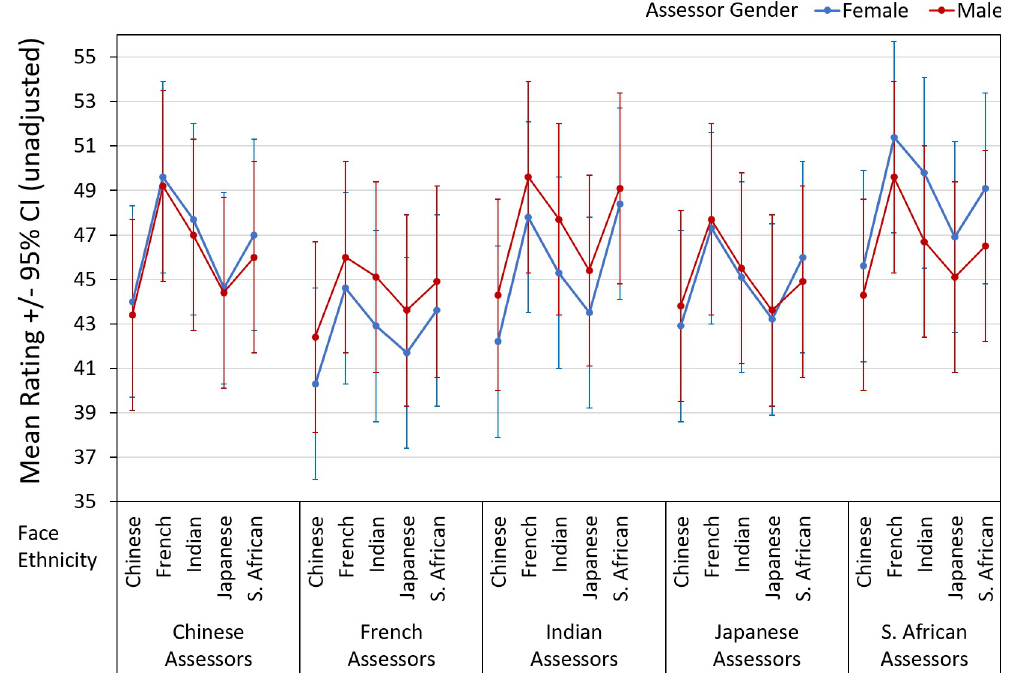
Fig 3. Assessments of facial images, by participant (“face”) ethnicity, assessor ethnicity and gender for age.